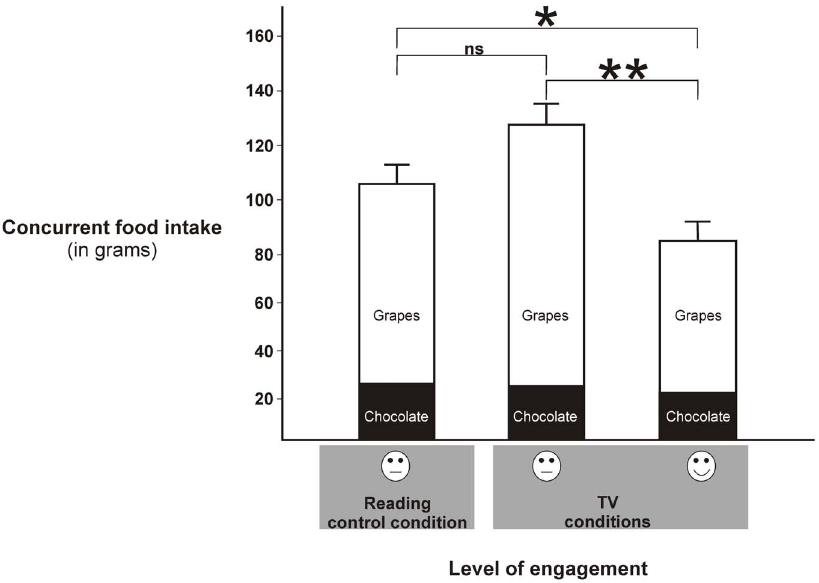
Figure 1. Food intake by condition. Figure detailing the total consumption (in grams) of both low calorie (grapes) and high calorie (chocolate) snacks during both Boring and Engaging (comedy) TV viewing and in the control Text condition. There was significantly more overall consumption in the Boring TV condition relative to both the Text and Engaging TV conditions. Additionally, there was significantly less gross consumption in the Engaging TV condition relative to the Text control. There was also a borderline significant interaction effect such that these changes in consumption were driven primarily by low-calorie snacks (grapes). * # 0.05, ** , 0.01.